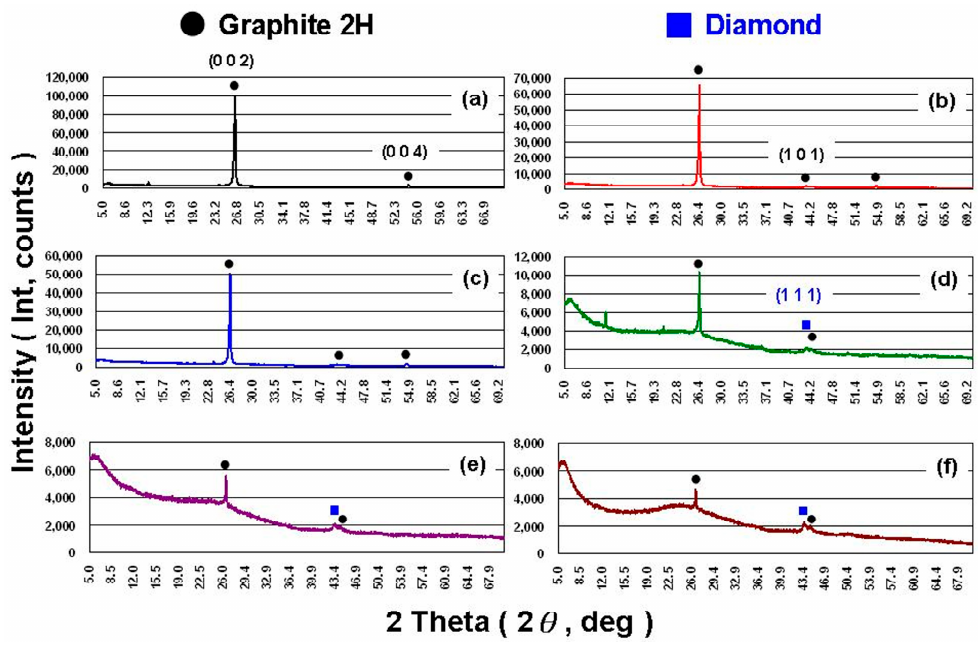
Figure 4. X-ray diffraction (XRD) patterns of the MNCBMs: ( a ) GP, ( b ) 0.5 MPa, ( c ) 1.0 MPa, ( d ) 1.5 MPa, ( e ) 2.0 MPa, and ( f ) 2.5 MPa.